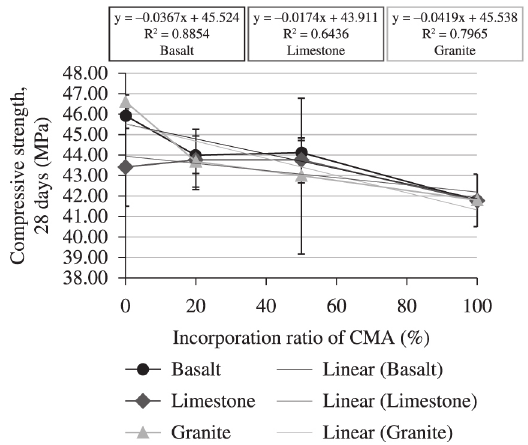
Figure 6. Compressive strength at 28 days.